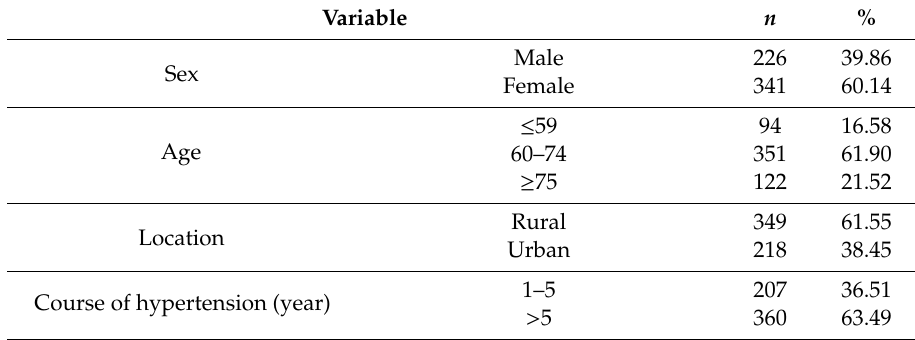
Table 1. Demographic and socioeconomic characteristics of hypertensive patients, survey in